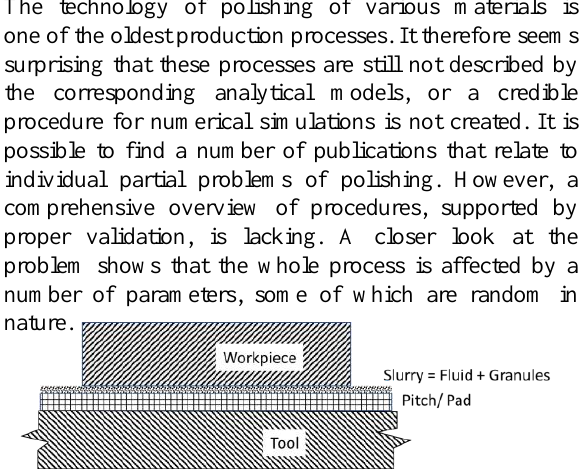
Fig. 1. Basic components of the polishing process.